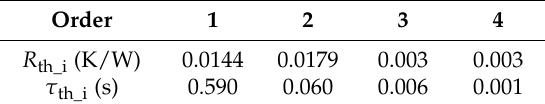
Table 3. Parameters of foster-based thermal network.